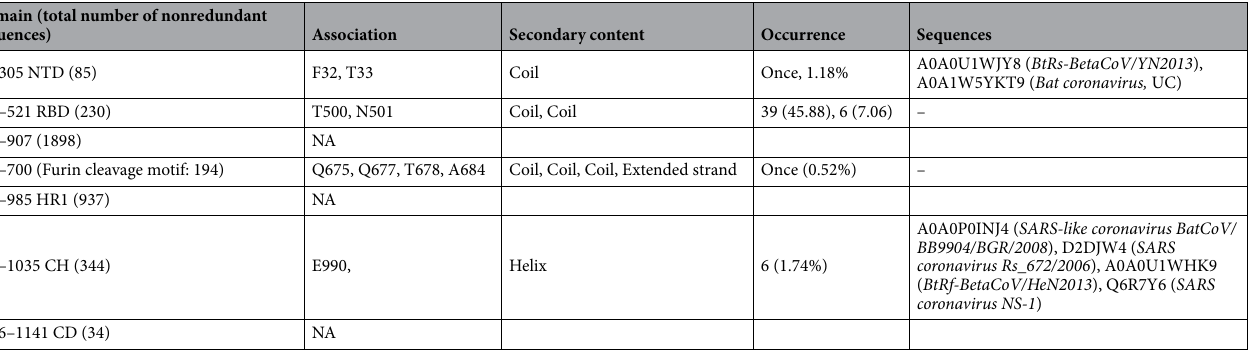
Table 3. Correspondence analysis. Introducing the key residues in each